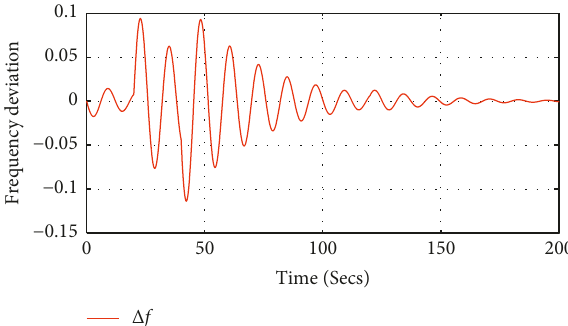
Figure 3: Evaluation of △ f in equation (11) in Theorem 2.